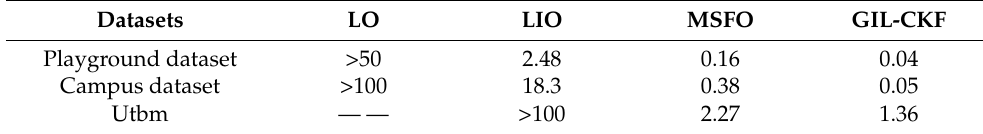
Table 4. Cumulative error (unit: